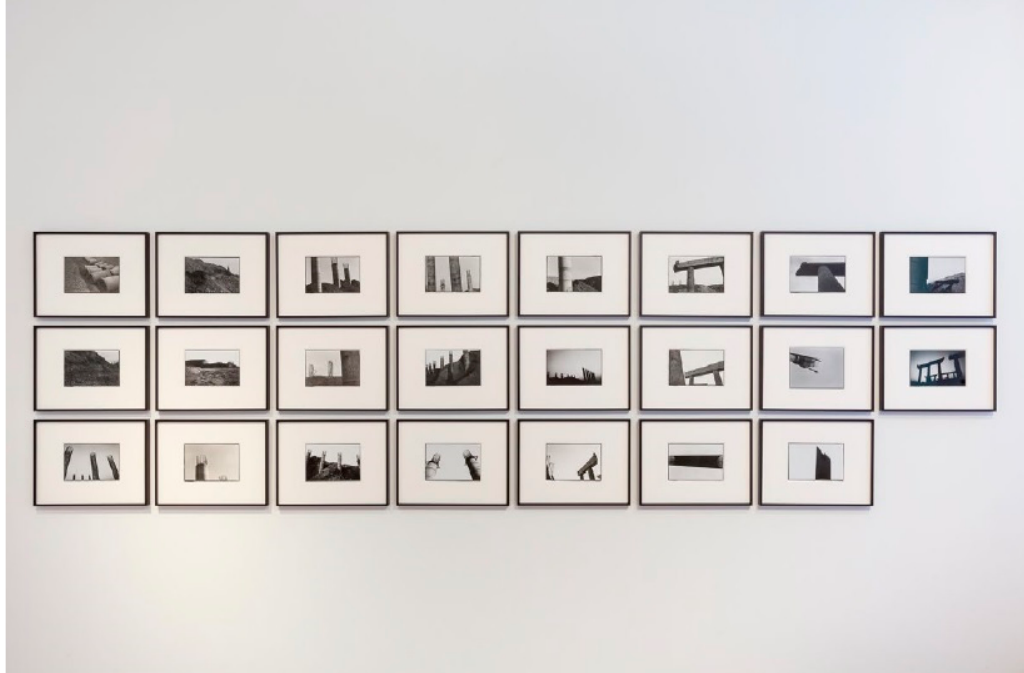
Figure 7. Mohammad Ghazali, from the Persepolis 2560–2580 series, installation view, Ab-anbar Gallery, London 2021.